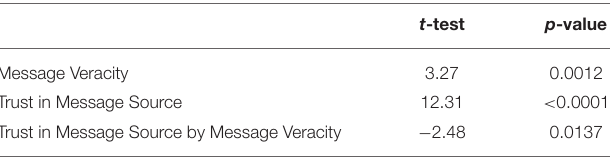
TABLE 2 | Interaction of source trust and message veracity on message